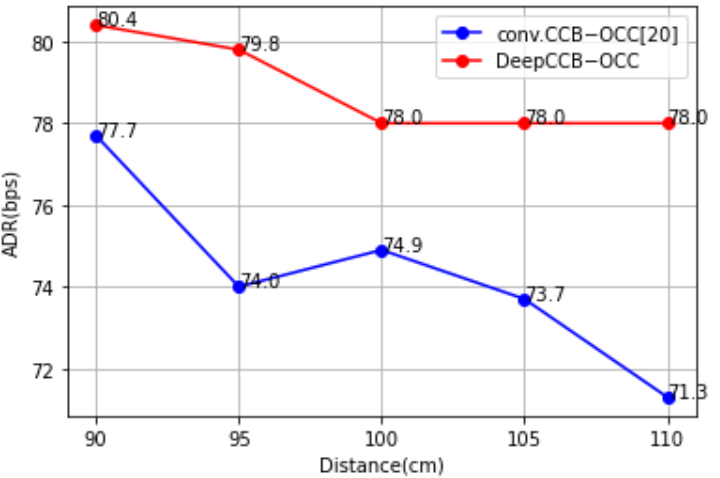
Figure 12. Achievable data rate performance according to distance between the display and the camera. Data adapted from [20]. 2020 Sung-Yoon Jung et al.